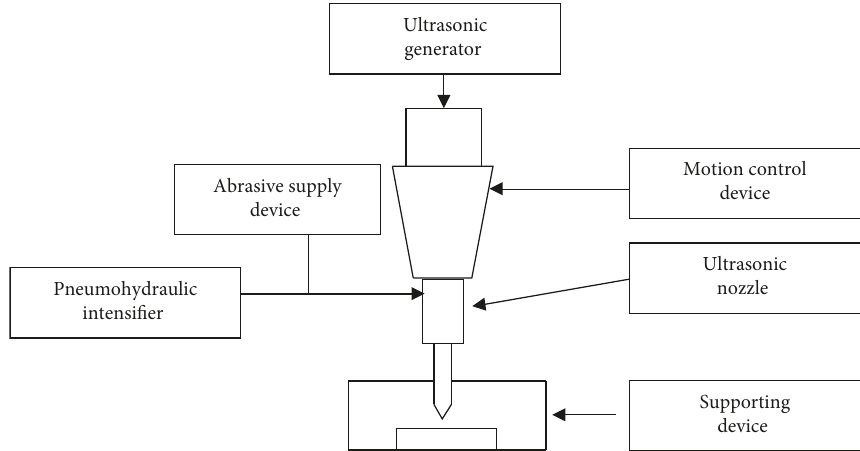
Figure 1: The device of ultrasonic vibration-assisted abrasive